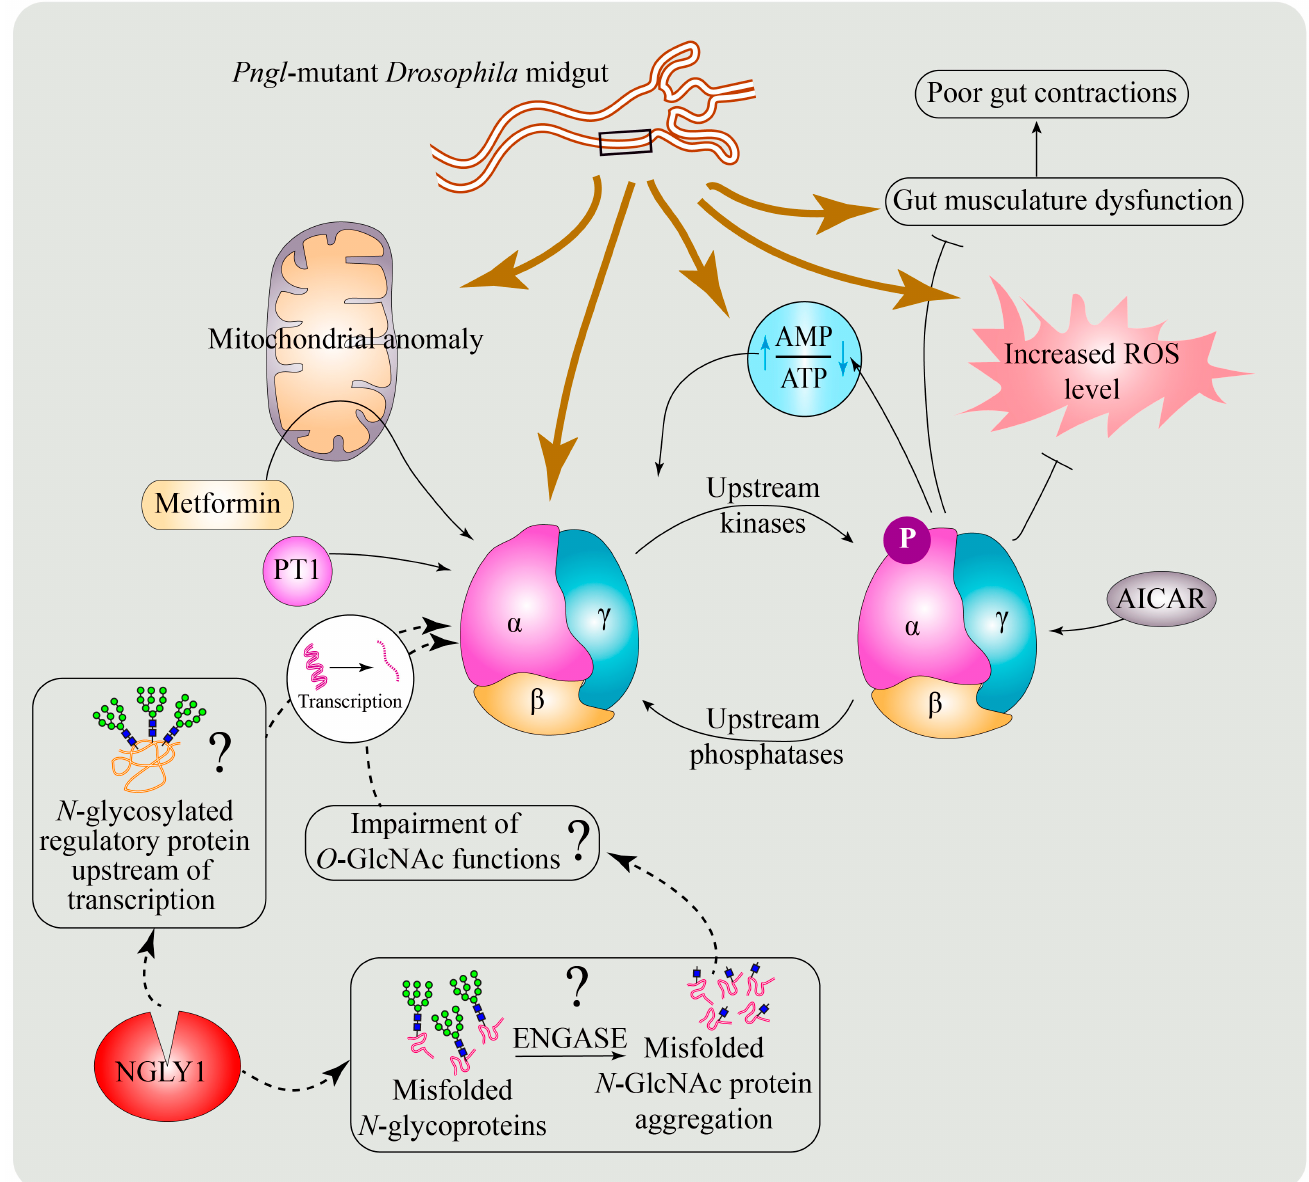
Figure 5. Schematic representation showing poor gut contraction in Pngl -mutant Drosophila midgut accompanied by reduced AMP-Activated Protein Kinase α (AMPK α ) levels, increased AMP/ATP ratio, increased reactive oxygen species (ROS) levels, and mitochondrial anomaly. The cartoon also shows the AMPK activators metformin, PT1, and AICAR, as well as the possible mechanisms for regulation of AMPK α mRNA levels by NGLY1. NGLY1 might affect AMPK α transcription by altering specific upstream N -glycosylated proteins. In the absence of NGLY1, ENGASE may result in the accumulation and aggregation of proteins with N -GlcNAc residues, which might interfere with the function of proteins harboring O -GlcNAc. “?” marks potential mechanisms for the Regulation of AMPK α mRNA level by NGLY1.